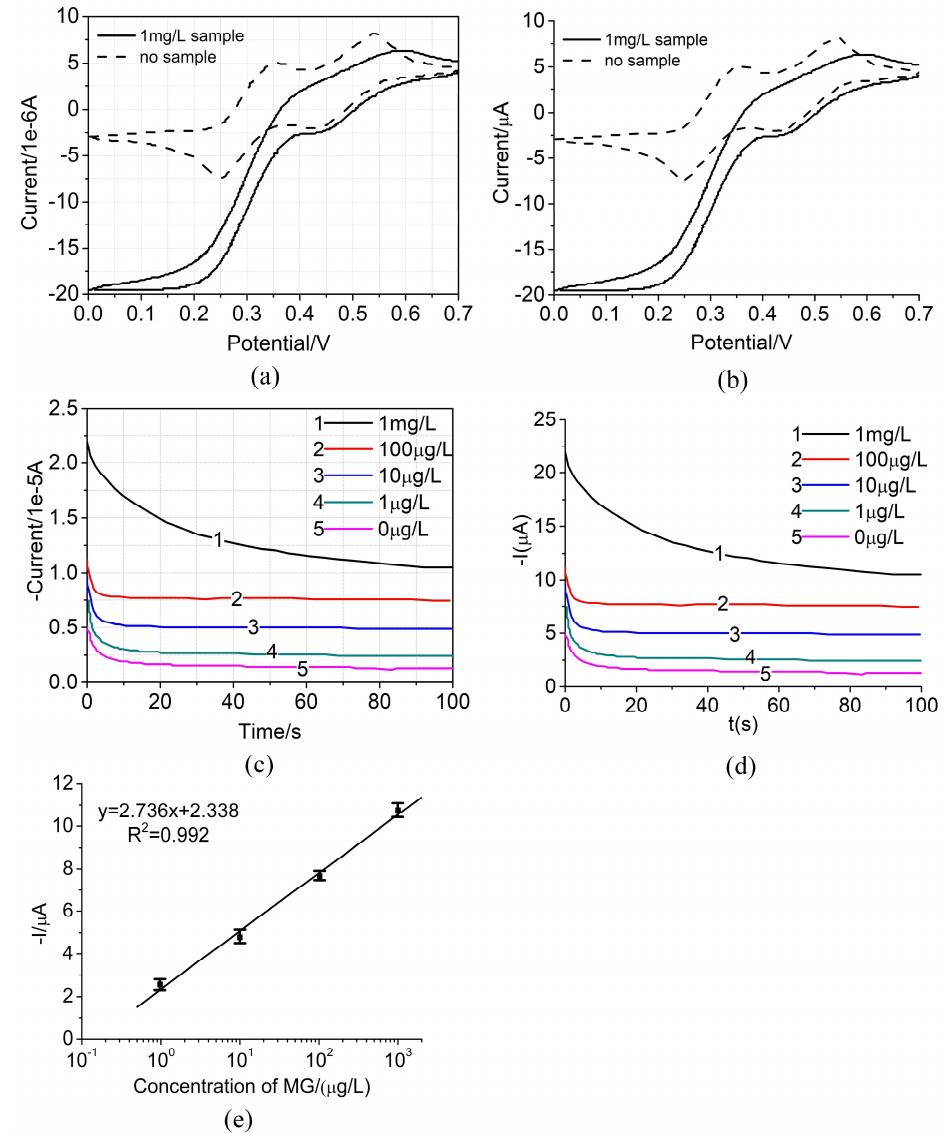
Figure 7. Detection performance of MG. ( a ) Cyclic voltammograms for no target (dashed line) and 1 mg/L target (solid line) obtained from commercial electrochemical instrument. ( b ) Cyclic voltammograms for no target (dashed line) and 1 mg/L target (solid line) obtained from the hand-held electrochemical instrument in this system. ( c ) Amperometric curves of samples with different concentrations (1 mg/L, 100 μg/L, 10 μg/L, 1 μg/L and 0 μg/L) in TMB substrate solution obtained from commercial electrochemical instrument. ( d ) Amperometric curves of samples with different concentrations (1 mg/L, 100 μg/L, 10 μg/L, 1 μg/L and 0 μg/L) in TMB substrate solution obtained from the hand-held electrochemical instrument in this system. ( e ) A calibration plot of the amperometric current and the log concentration of target. Data were collected from at least three independent experiments.